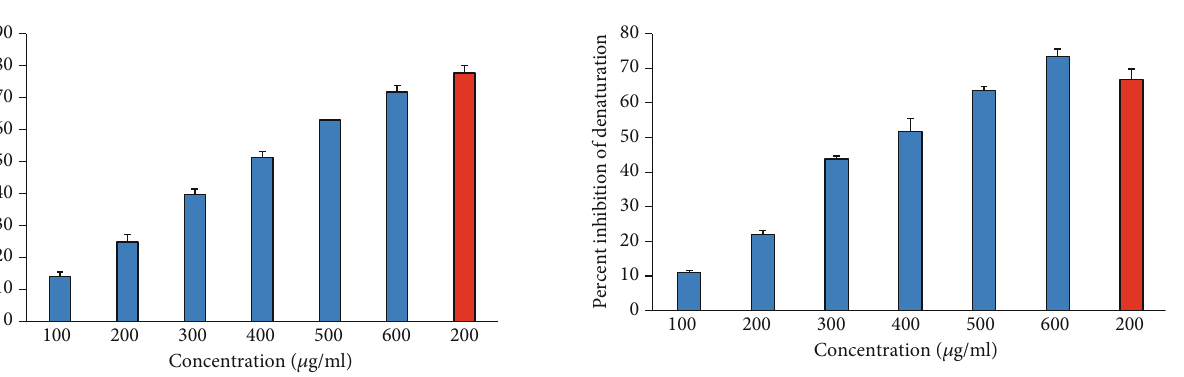
Figure 2: The percentage inhibition of heat-induced denaturation. Columns (from 1 to 6) at x -axis represent concentration 100- 600 μ g/ml of 6-gingerol. Red colored column shows 200 μ g/ml of ibuprofen. The results are presented as means ± SEM ( n = 3 , p < 0 : 05 ).